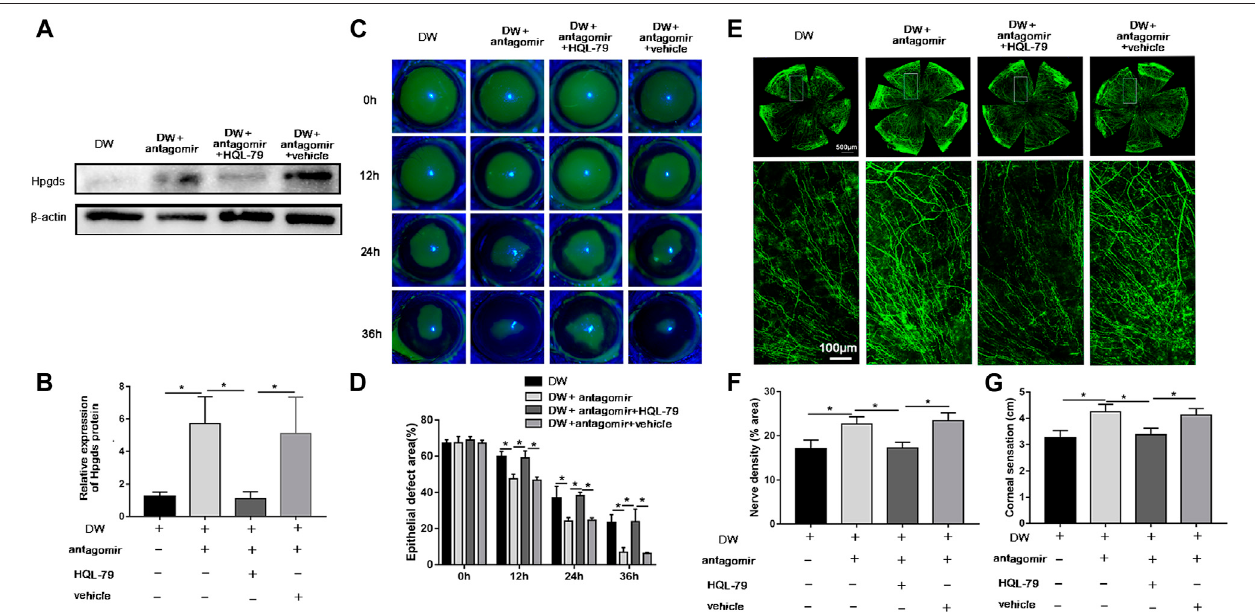
FIGURE6| BlockadeofHpgdscounteractsthebene fi cialeffectsinducedbymiR-223-5pantagomir. (A,B) Westernblottingassayshowingtheproteinexpression of Hpgds in the cornea 24 h post-wounding ofdiabeticmice (DW group), miR-223-5p antagomirtreated diabetic mice(DW + antagomir group), miR-223-5p antagomir andHQL-79treateddiabeticmice(DW+antagomir+HQL-79group),miR-223-5pantagomir,andvehicletreateddiabeticmice(DW+antagomir+vehiclegroup). (C,D) Fluorescence staining assay showing the corneal epithelial defect areas of DW group, DW + antagomir group, DW + antagomir + HQL-79 group and DW + antagomir+vehiclegroupatdifferenttimepointspost-injury. (E,F) Cornealwhole-mountstainingof β -tubulinIIIrevealingthecornealnervesofeachgrouponday5post- wounding. (G) Corneal sensation measurement was conducted on day 5 post-wounding in each group. (B,D,F,G) Data were analyzed by One-way ANOVA. If signi fi cant, multiple comparations were then performed. * p -value of <